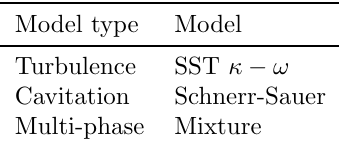
Table 4: CFD model